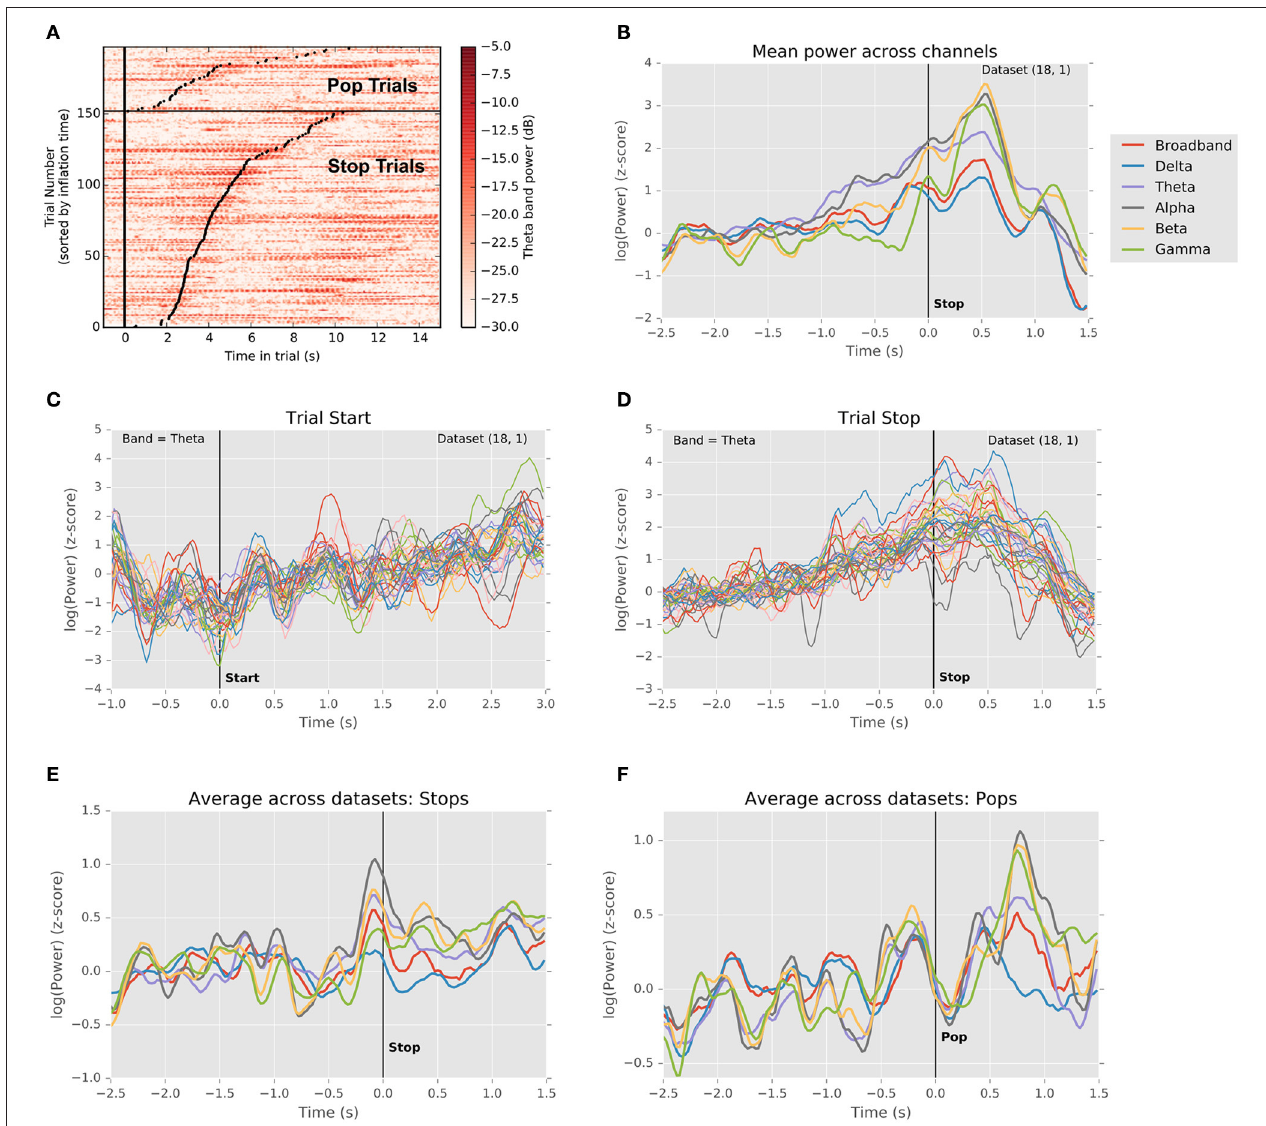
FIGURE 3 | Changes in local field potential over the course of the trial. (A) Raster plot of power in the theta frequency range (4–8Hz) for each trial in a single dataset (18.1). Each line represents one trial, with trials ordered vertically by duration. Successful stops are plotted below unsuccessful stops (balloon pops). Left vertical black line indicates trial start. Black dots indicate trial stops. Color indicates theta-band power in dB. A clear increase in theta power precedes successful stops. (B) Normalized LFP power rises preceding stops. Traces depict mean (across channels) of medians (across successful stop trials) LFP power in delta, theta, alpha, beta, and gamma frequency bands, as well as broadband signal, aligned to the time of the stop ( t = 0). Power in theta band rises preceding the stop, falling gradually thereafter, whereas power in alpha and beta bands dips prior to the stop, rises sharply thereafter, and falls abruptly during the outcome period. (C) Normalized theta band LFP power in each channel aligned to trial start (t = 0). Traces indicate medians across trials (one trace per channel). Theta power dips just prior to trial onset and begins to rise as the balloon inflates. (D) Normalized theta band power in each channel aligned to trial stop. Traces represent medians across successful stop trials (one trace per channel). Power increases until the stop, following which it declines toward its pre-trial baseline. (E) Grand mean (averaged across datasets) trajectory of power in different frequency bands preceding voluntary stops ( t = 0). Conventions are as in (A) . Note that multiple frequency bands exhibit changes in power preceding stops. (F) Grand mean (averaged across datasets) trajectory of power in different frequency bands preceding involuntary stops (i.e., pops; t = 0). Conventions are as in (A) . Note the sharp rise in power during the outcome phase, similar to the rise in power preceding voluntary